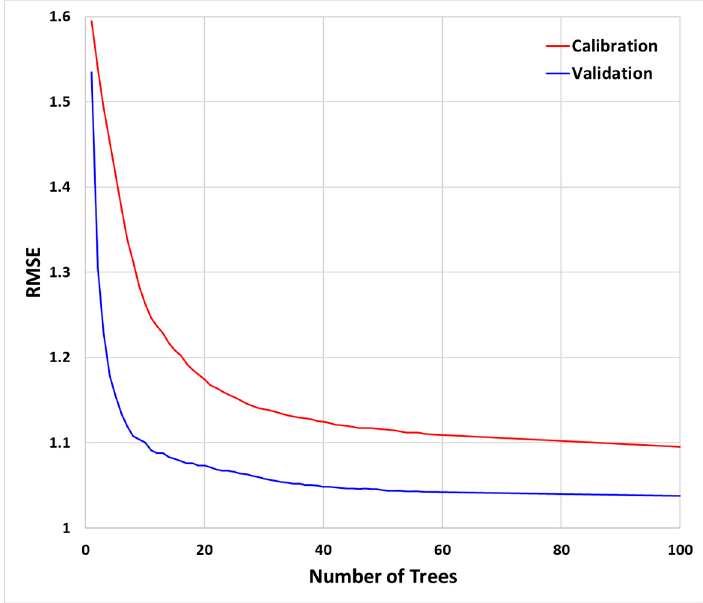
Figure 3. The changes in the root mean square error (RMSE) according to the number of trees in the calibration/validation process of the random forest (RF) modeling. The RMSEs almost converged when the number of trees is around 100.